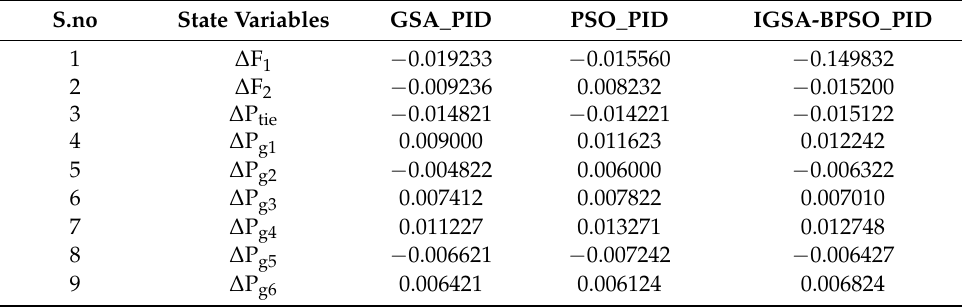
Table 6. Overshoot values (s) for different optimization techniques